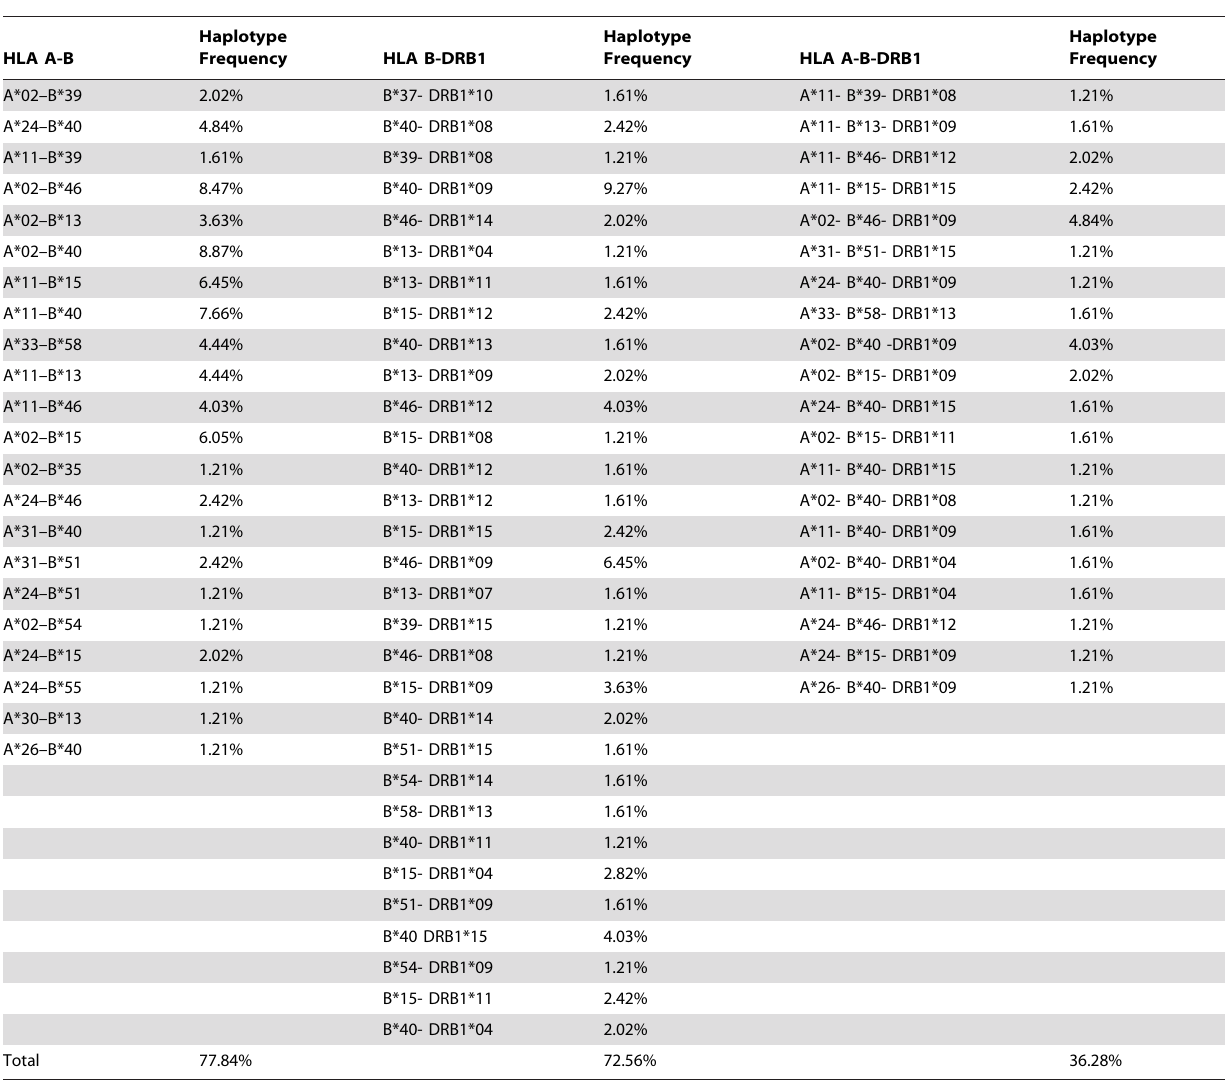
Table 3. Main high-frequency HLA haplotypes and their frequencies of Tujia population (haplotype frequency $